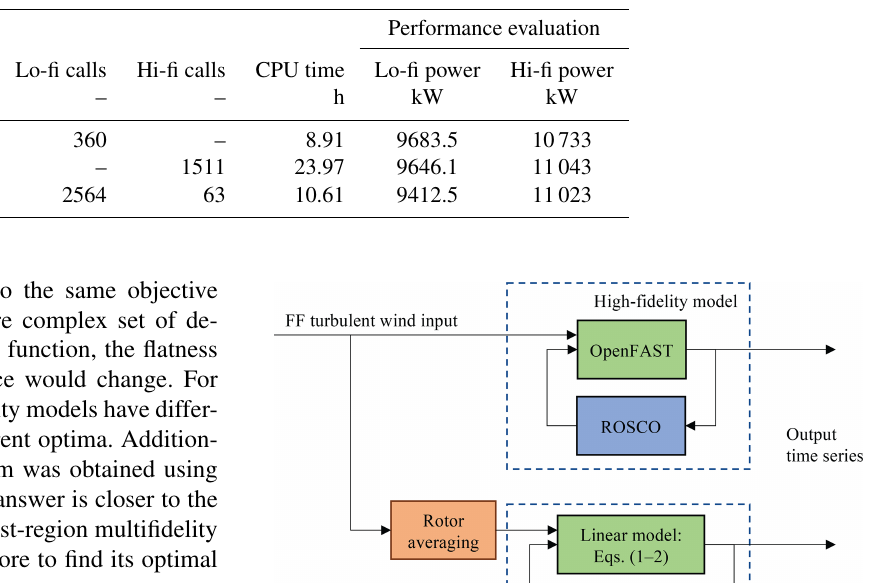
Table 2. Optimal results for aerodynamic blade power maximization.